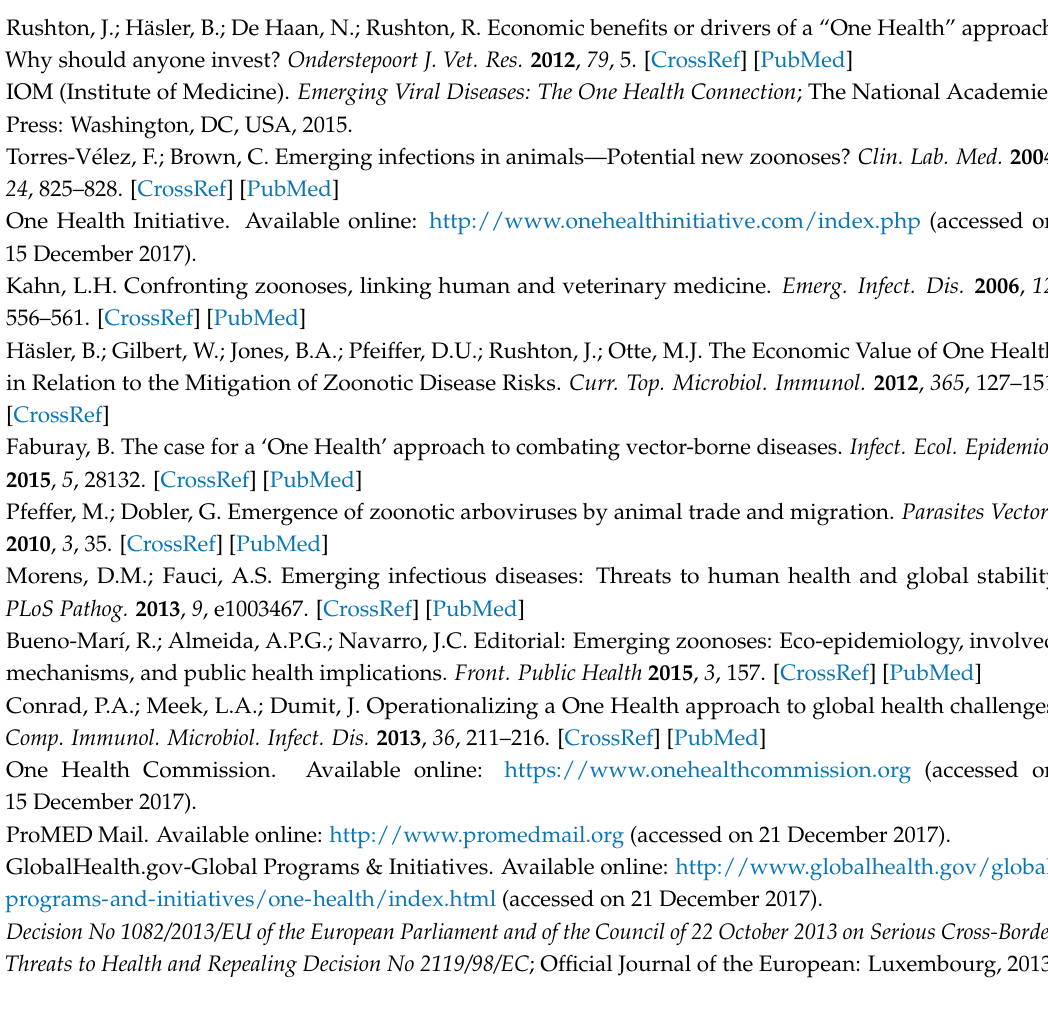
Table S1: Eligible articles; Table S2: Eligible documents; Table S3: PubMed database; Table S4: Scoping Review